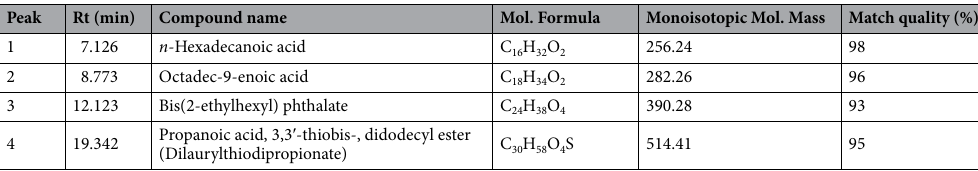
Fig. S3, Supplementary Table S3) and ethyl acetate fractions (Supplementary Table S4) revealed the presence of many more compounds such as tocopherol, squalene, and octadecanoic acid among others. HPLC UV/Vis analysis. HPLC UV/Vis analysis of the DCM fraction with UV absorption at 215 and 254 nm indicated the presence of a large number of metabolites. Further HPLC analysis of the n -butanol fraction at 254 and 350 nm indicated the presence of phenolic compounds likely flavonoids with stronger absorbance at 350 nm (Supplementary Fig. S4).